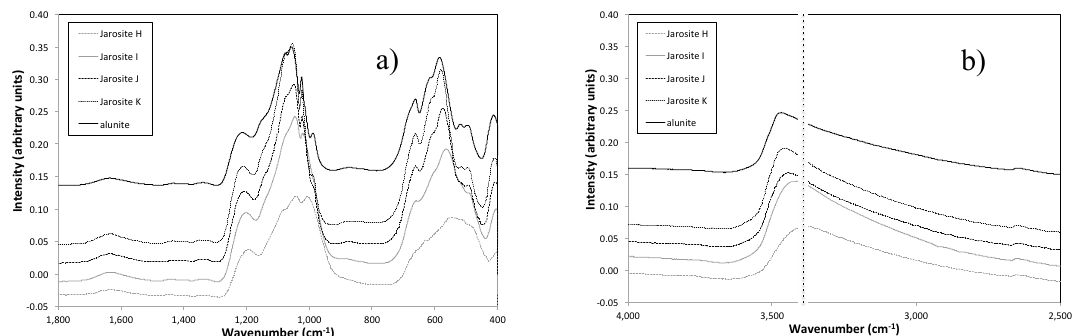
Figure 10. FTIR spectra of solids formed at on addition of 0.9–1.0 mole fraction Al. ( a ) 400–1800 cm − 1 region and ( b ) 2500–4000 cm − 1 region. Spectra have been offset in the y -direction for clarity.